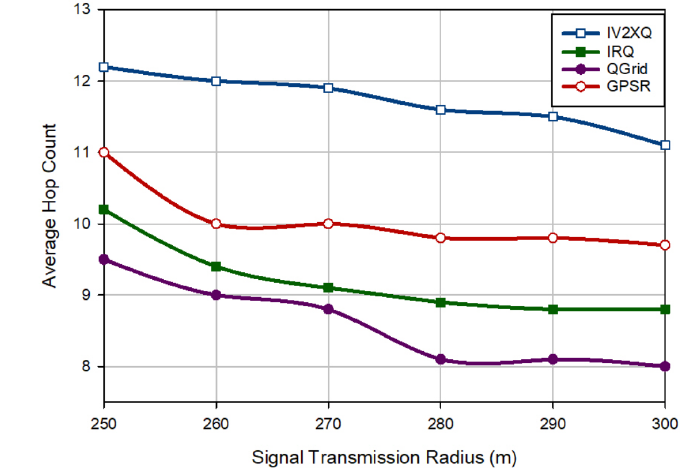
Figure 9. Comparison of the hop count in different routing methods based on